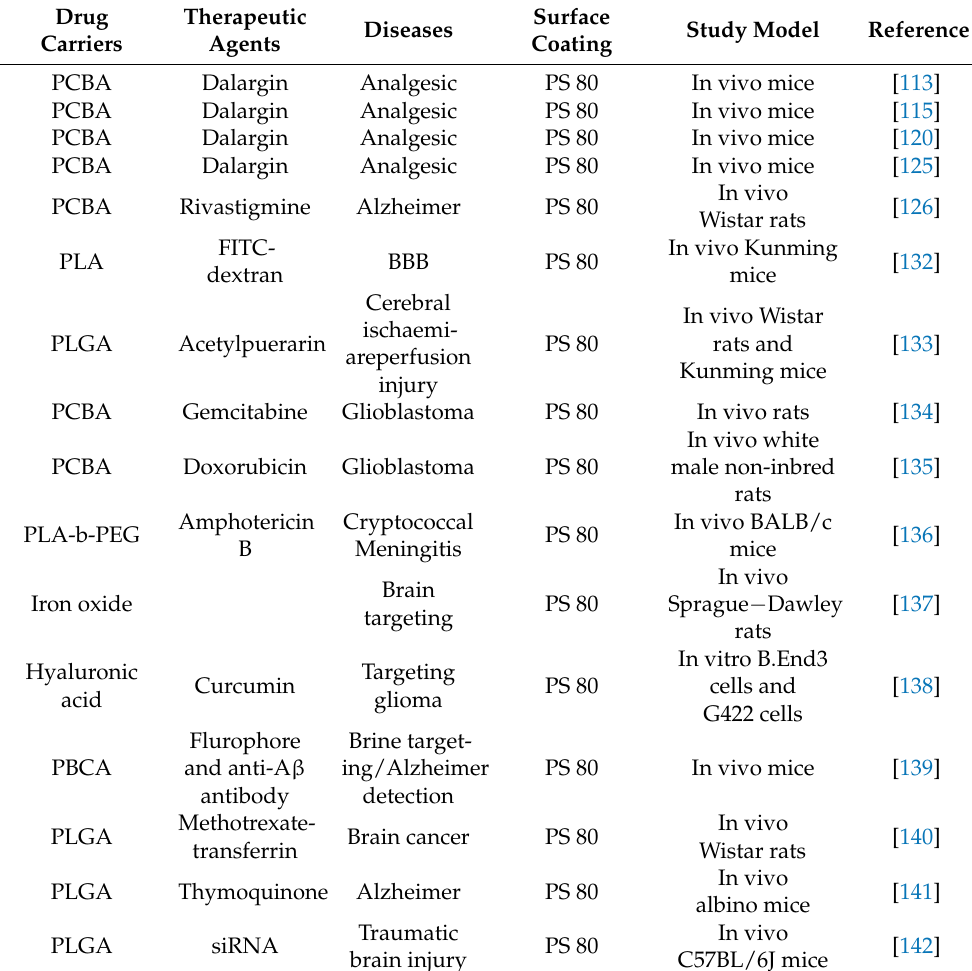
Table 1. Various PS-coated NPs for brain-targeted